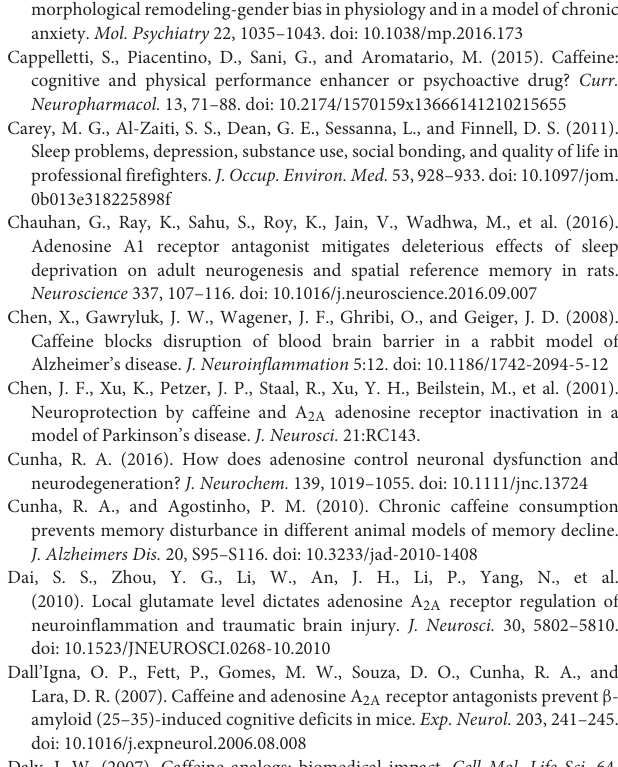
FIGURE S2 | Fold changes in the inflammatory cytokines in plasma during caffeine/modafinil administration following SD. Fold changes in (A) TNF- α ; (B) IL-1 β ; (C) IL-6 (pro-inflammatory cytokines); (D) IL-4; (E) IL-10 (anti-inflammatory cytokines) in plasma. ∗ p < 0.05 when compared to control treated with vehicle; φ p < 0.05 when compared to sleep deprived treated with vehicle. Two way ANOVA followed by Tukey post hoc test with multiple comparison was applied for statistical